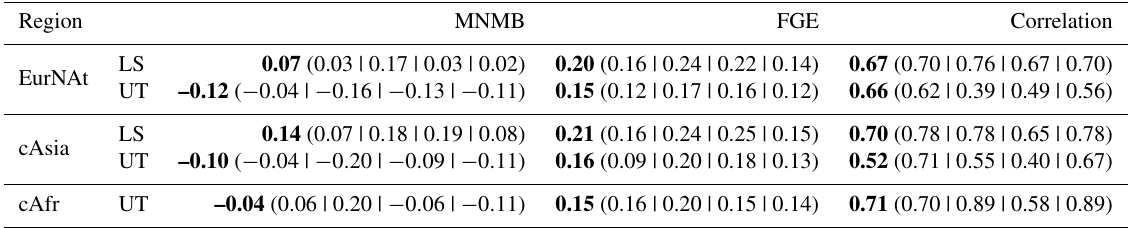
Table 4. Statistical scores comparing the INJH MOCAGE simulation against the IAGOS measurements in the three geographical regions defined in Fig. 1. The annual mean of each score is written in bold, followed by the seasonal mean in brackets as follows (DJF | MAM | JJA | SON).